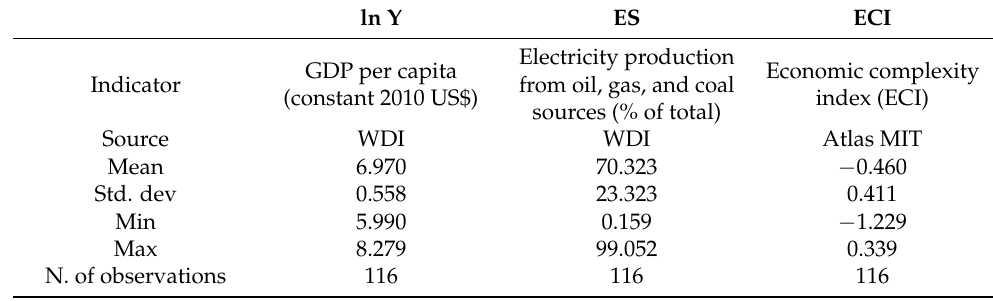
Table 1. Descriptive statistics.